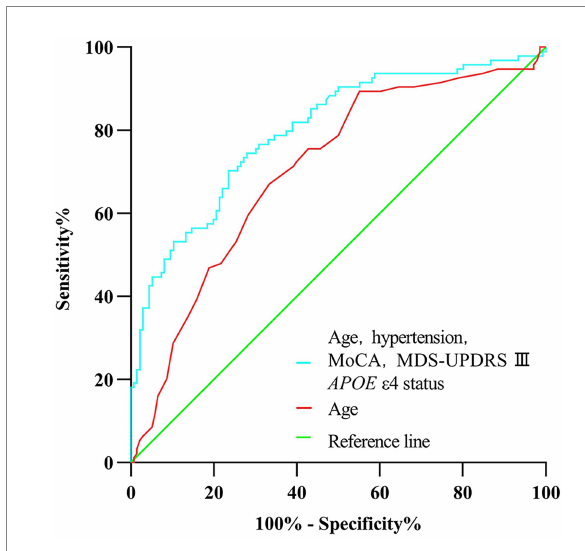
FIGURE 2 Receiver operating characteristic curve of prediction of cognitive impairment developed during the 5-year follow-up in newly diagnosed Parkinson’s disease patients (less than 2 years) with normal cognition at